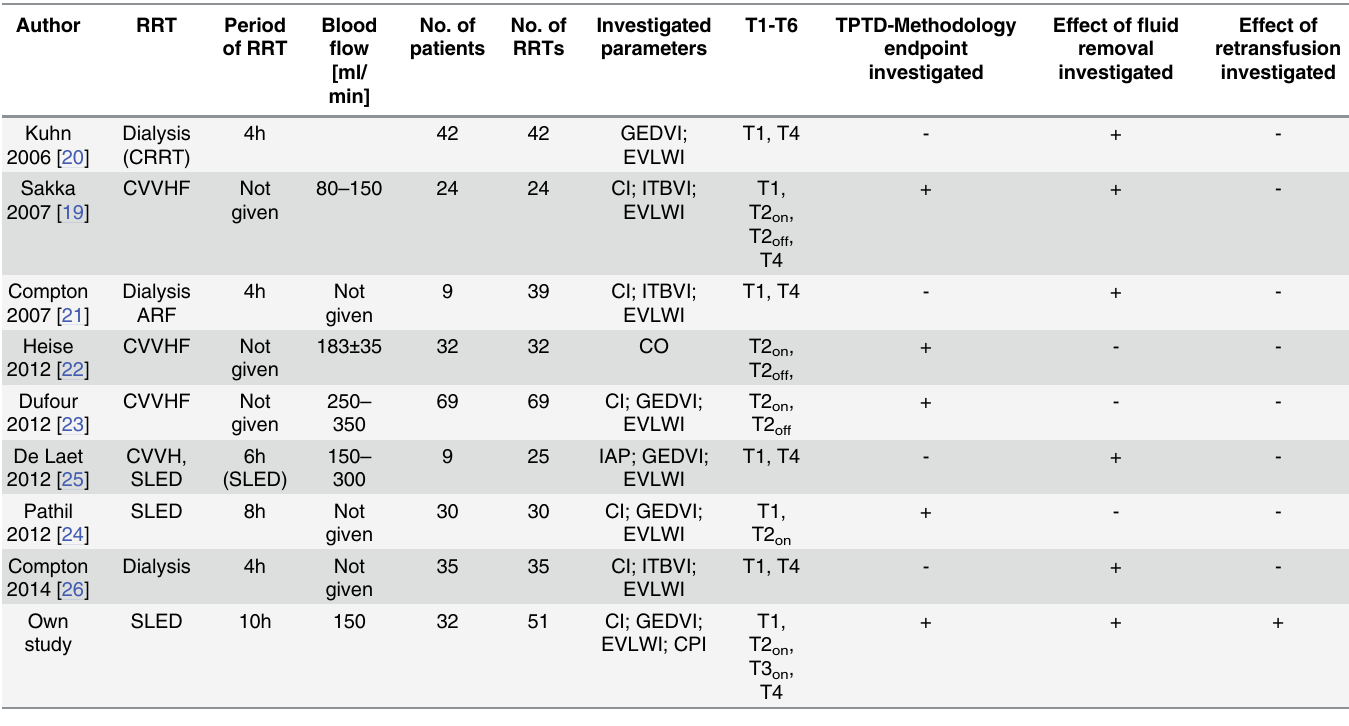
Table 2. Studies investigating TPTD and PCA in